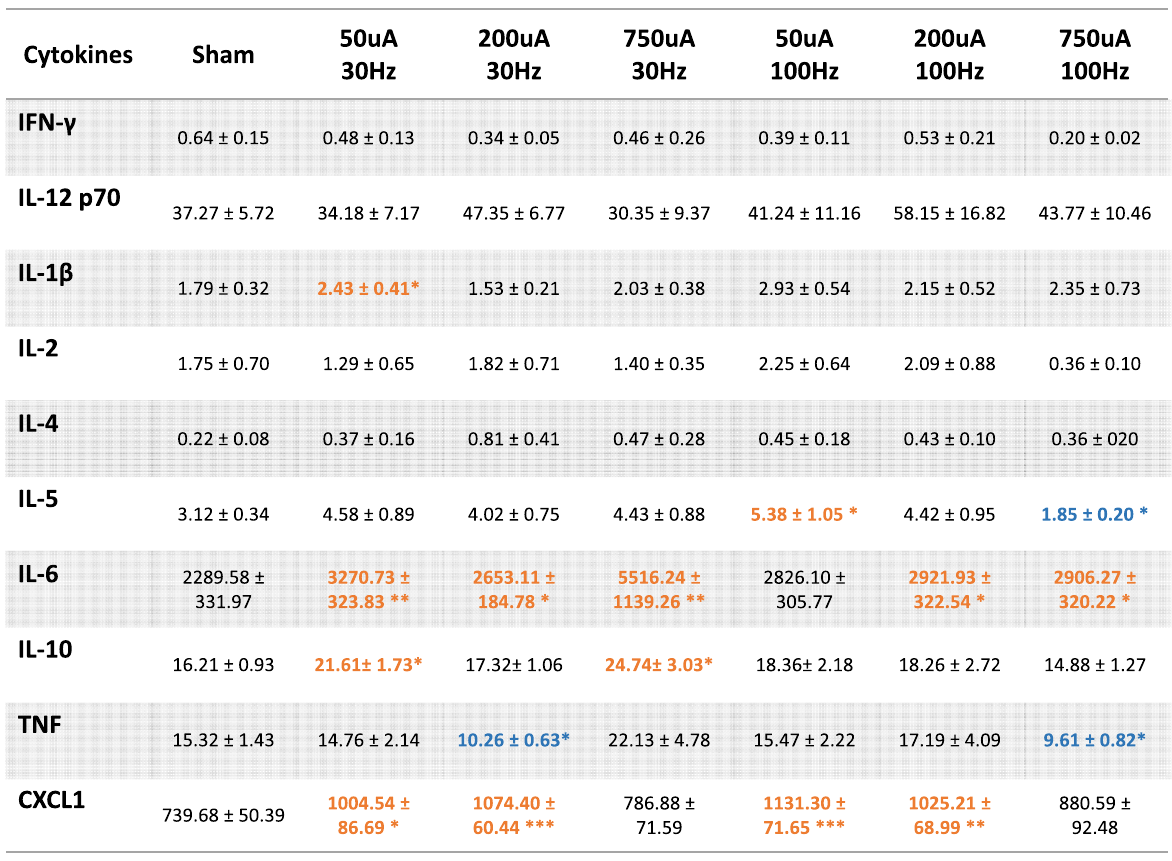
Table 1 Cytokines (mean ± SEM) at 50 μ s